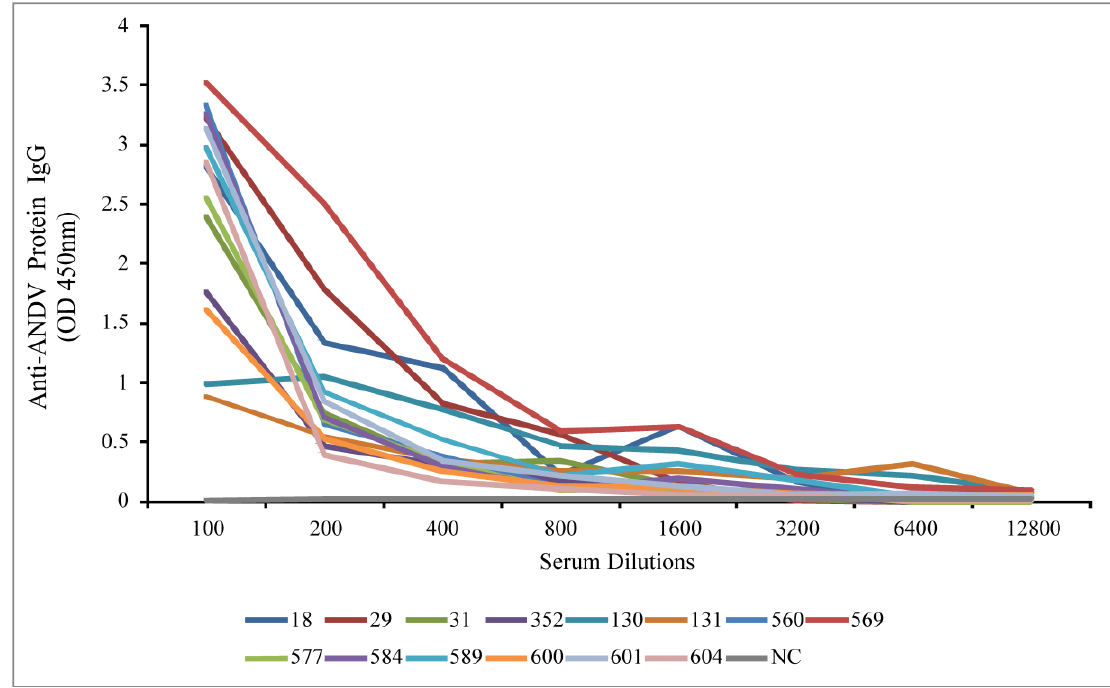
Figure 1. Quantitative enzyme-linked immunosorbent assay (ELISA) results. The graphics shows variations of optical density (O.D.) values measured in seropositive samples at different dilutions of sera. NC: Negative